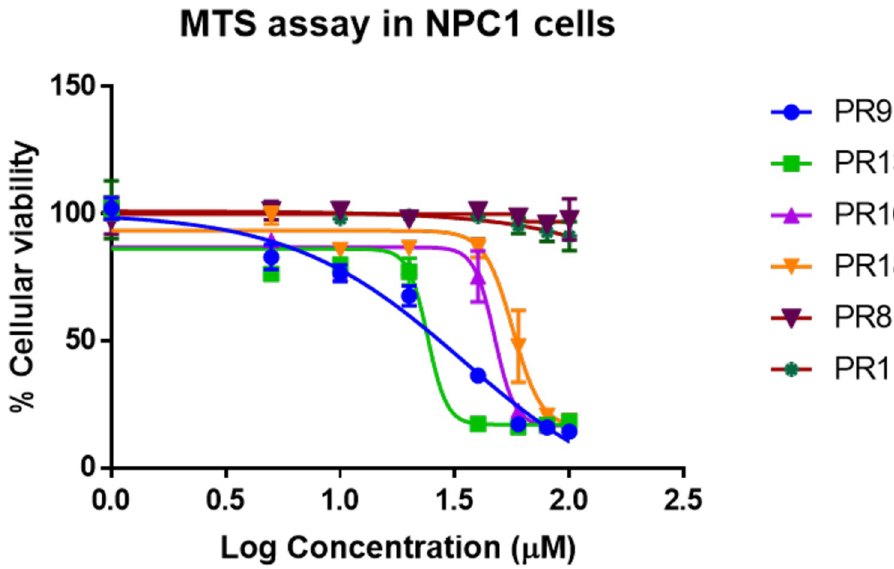
Fig 5. Cytotoxicity analysis of compounds prepared by solid phase synthesis vs solvent-assisted synthesis. NPC1-deficient cells (1500 cells/well) were plated in a 96 well plate for 36 h before treatment with varying concentrations of PRs. Cells were incubated for a further 24 h before measuring toxicity of the compounds by MTS assay according to manufacturer’s protocol.